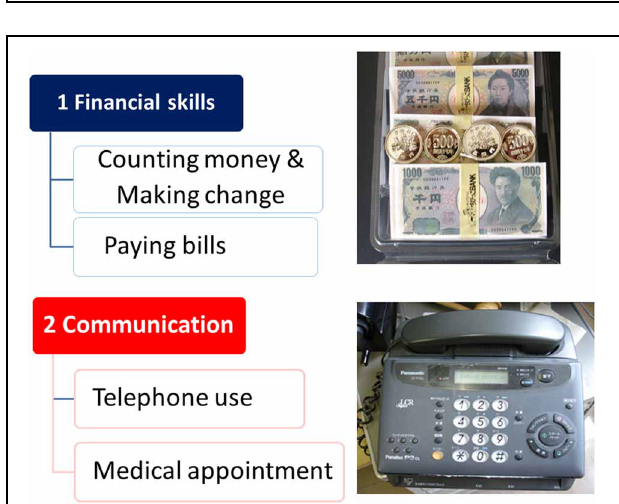
FIGURE 8 | UCSD Performance-based Skills Assessment—Brief version (UPSA-B).